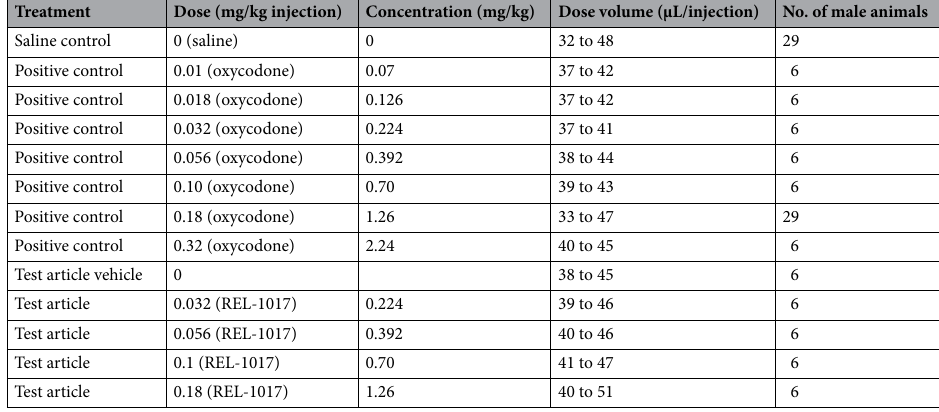
Table 1. Study design.